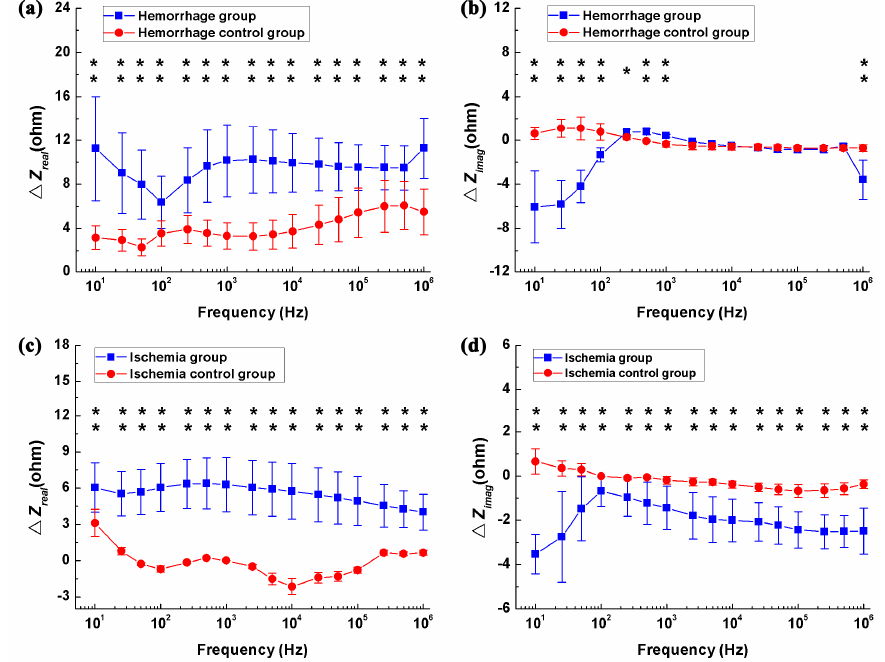
Figure 5. The change in the brain impedance spectra before and after stroke in relation to the control groups. ( a , b ) Real and imaginary parts of brain impedance differed in the hemorrhage group (measured before and after blood was injected) and its control (measured 1 min and 33 min after the needle was inserted); ( c , d ) Real and imaginary parts of brain impedance differed in the ischemia group (measured before and after irradiation with green cold light) and its control group (measured 15 min and 45 min after injection of rose bengal dye). ∆ Z denotes the brain impedance change between the brain impedance ( Z A and Z B ) measured at two time points (A and B, if A and B represent the two time points), i.e., ∆ Z = Z B − Z A . * p < 0.05, ** p < 0.01.